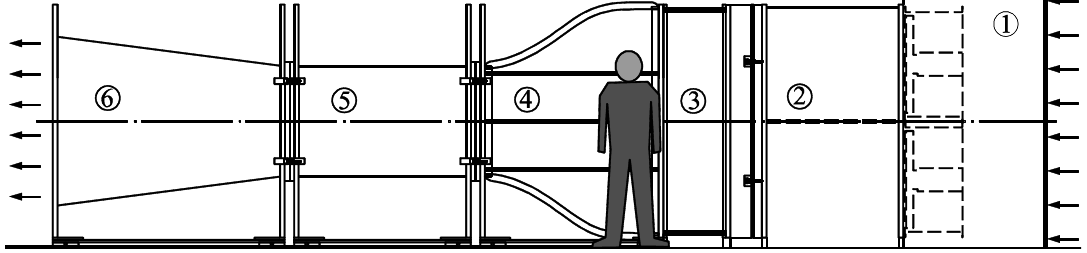
Figure 11. Sketch of the S4 wind tunnel at the IDR/UPM Institute used for anemometer calibration. The different parts of the wind tunnel are indicated in the figure as follows: 1. Fans; 2. Plenum chamber; 3. Honeycomb and grids; 4. Contraction; 5. Test chamber; 6. Diffuser. [11].